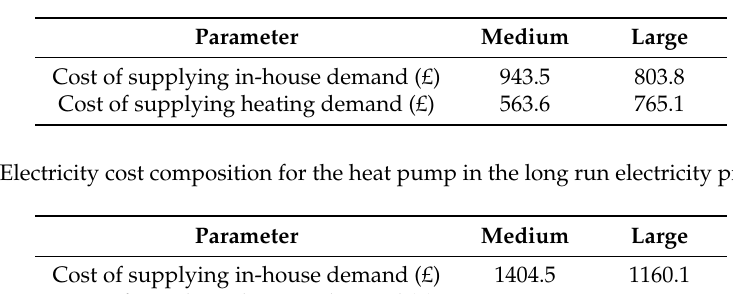
Table 5. Electricity cost composition for the heat pump in the short run electricity price regime.